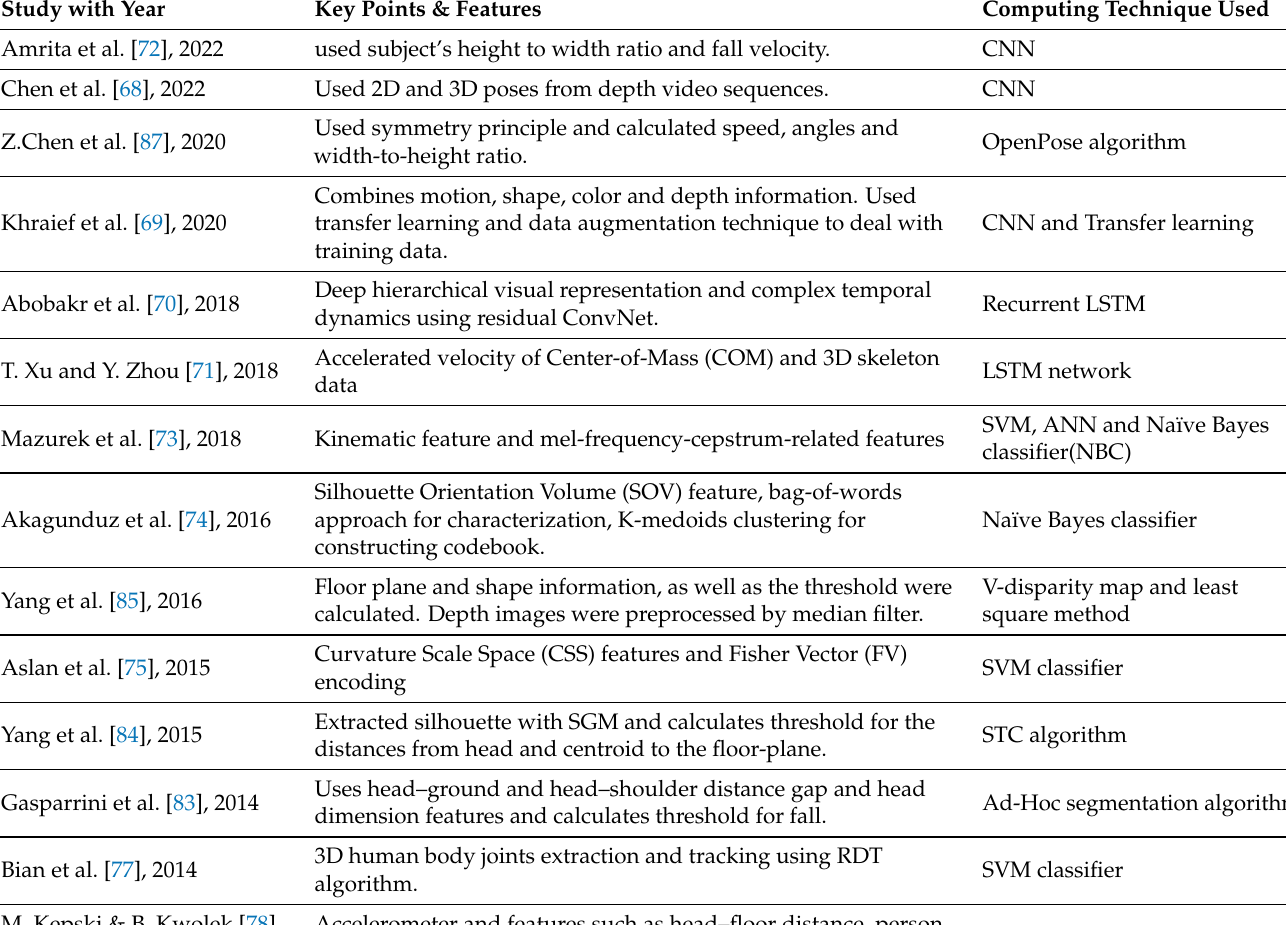
Table 1. Overview of the fall detection using depth imagery without gait parameter from the last